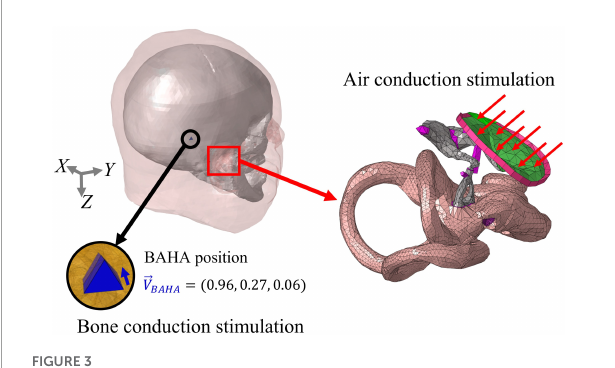
FIGURE3 Stimulation methods of air-conducted (AC) and bone conduction (BC) hearing. In AC stimulation, a distributed pressure is applied on the TM, with the outer bony shell of the cochlea, ends of the ligaments, and edge of the tympanic annulus being fixed. On the other hand, the BC input was stimulated on the screw elements at the BAHA position. The force was applied in the longitudinal direction of the screw and represented as a unit